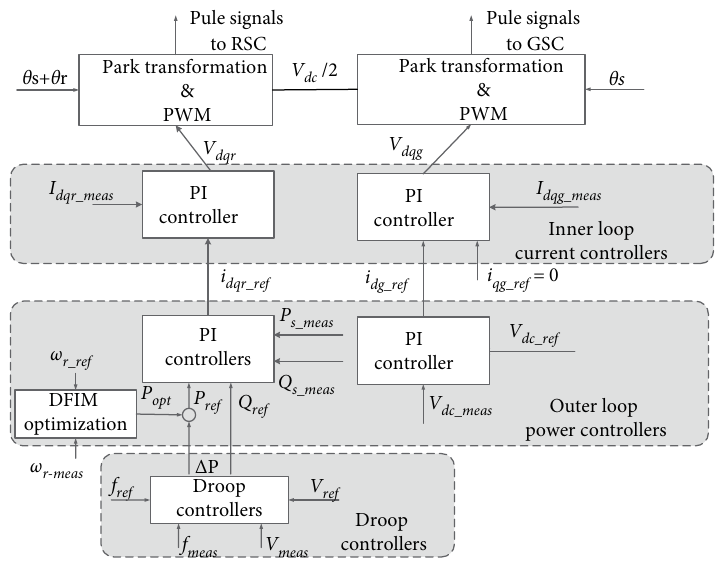
Figure 7: Overall structure of control strategy used in this paper implemented in the VSPS